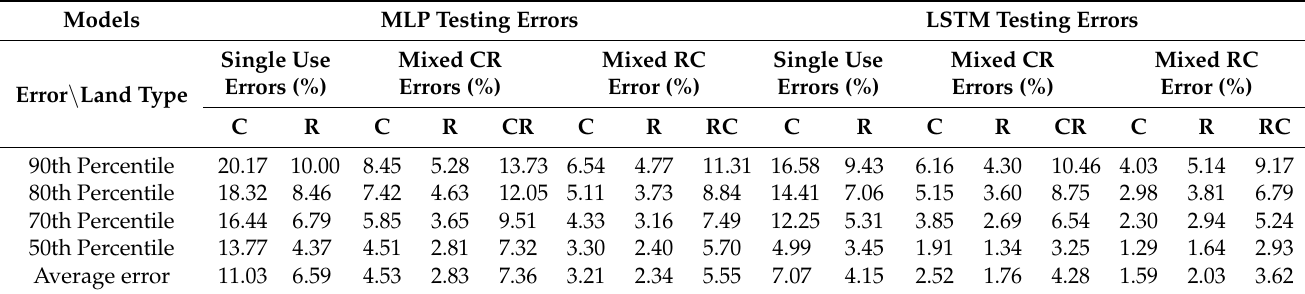
Table 8. Comparison of forecasting errors of MLP and LSTM